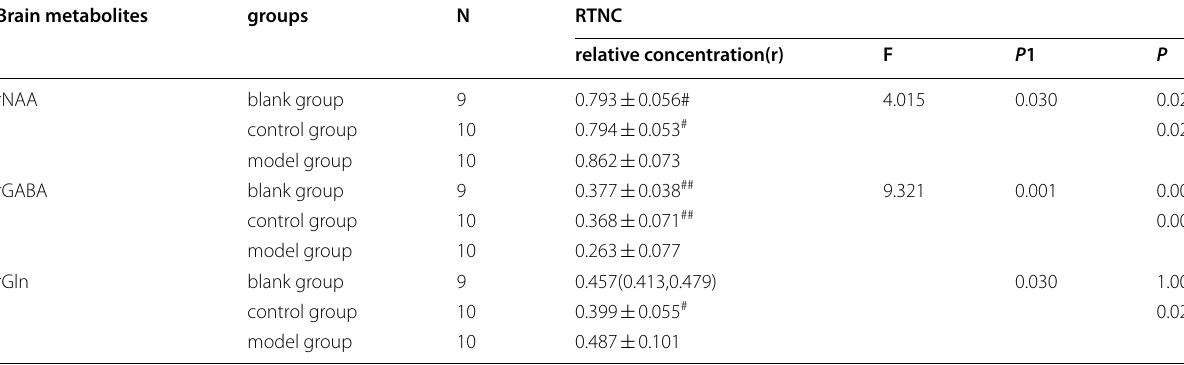
Notice: # Represents comparison with the model group, p < 0.05; ## Represents comparison with the model group, p < 0.01; P1 Indicates the p value of one-way analysis or Kruskal-Wallis H test